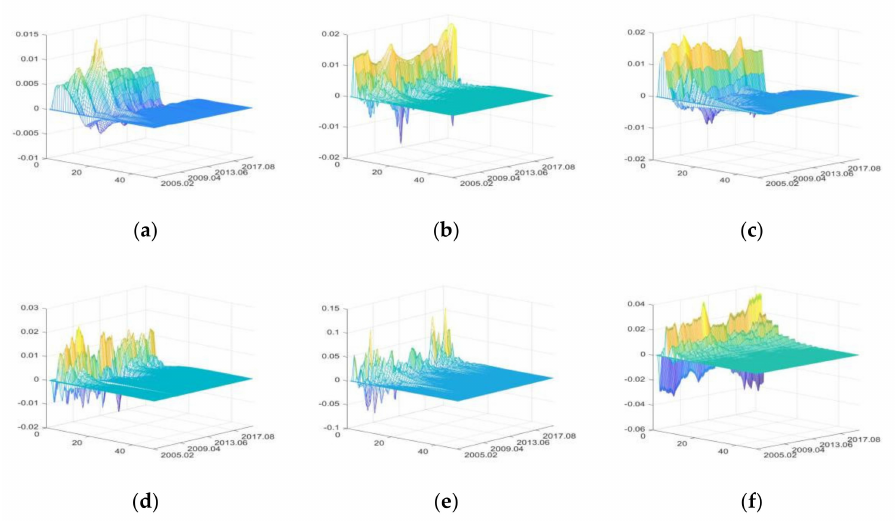
Figure 10. The three-dimensional impulse responses of PVFI to positive shocks of external uncer- tainties. ( a ) Shocks of IRU. ( b ) Shocks of FU. ( c ) Shocks of SDU. ( d ) Shocks of CU. ( e ) Shocks of DE. ( f ) Shocks of